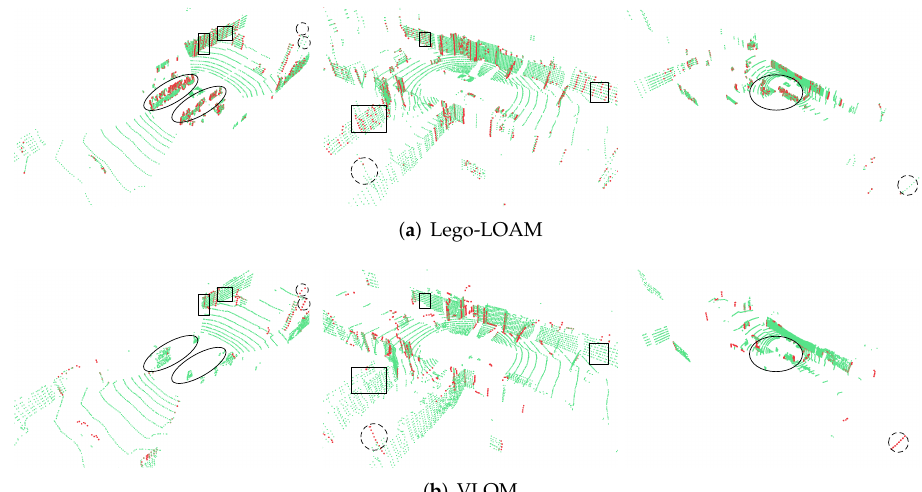
Figure 6. Comparison of the feature extraction results with Lego-LOAM and VLOM. ( a ) Features extracted with Lego-LOAM and ( b ) features extracted with VLOM. The green dots indicate planar feature points, while the red dots indicate the edge feature points. We marked some regions at the corresponding positions to compare the details of the two